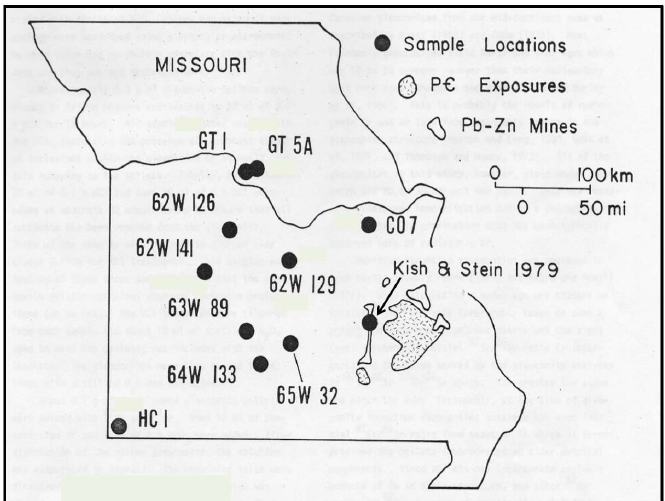
Figure 1. Location of the drill holes from which the glauconite-rich samples were collected in the Viburnum Trend of Missouri State (map of Posey et al.,[20], slightly modified).